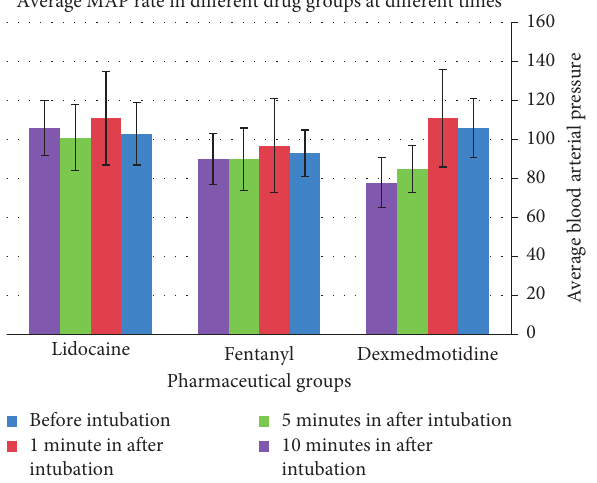
Figure 5: Comparison of MAP in the 1st, 3rd, 5th, and 10th minutes after intubation with before intubation in each group.